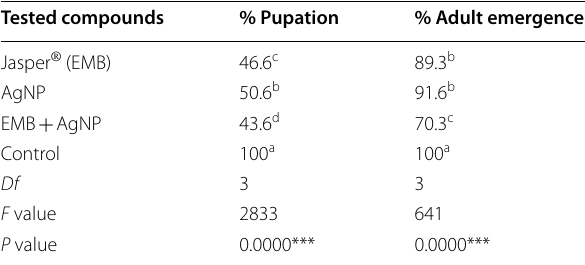
Table 3 Effect of the LC of the tested compounds on the rate 50 of pupation and adult emergence of survived individuals treated as fourth instar larvae of Spodoptera littoralis Tested compounds % Pupation % Adult